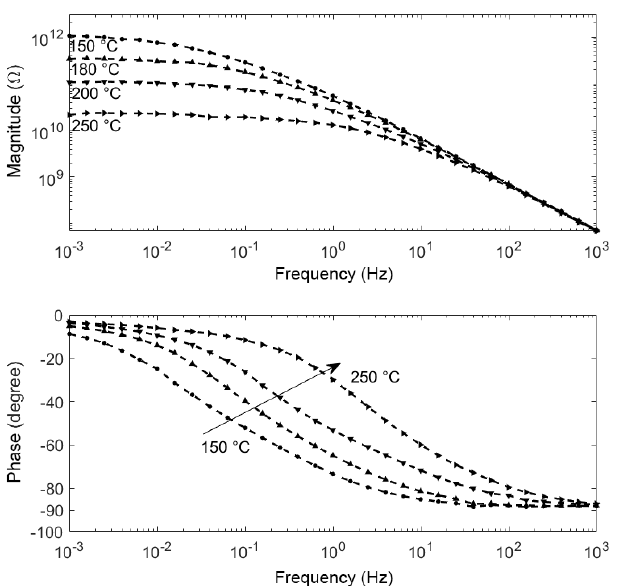
Figure 3. Bode plot of the sensor at different temperatures in dry